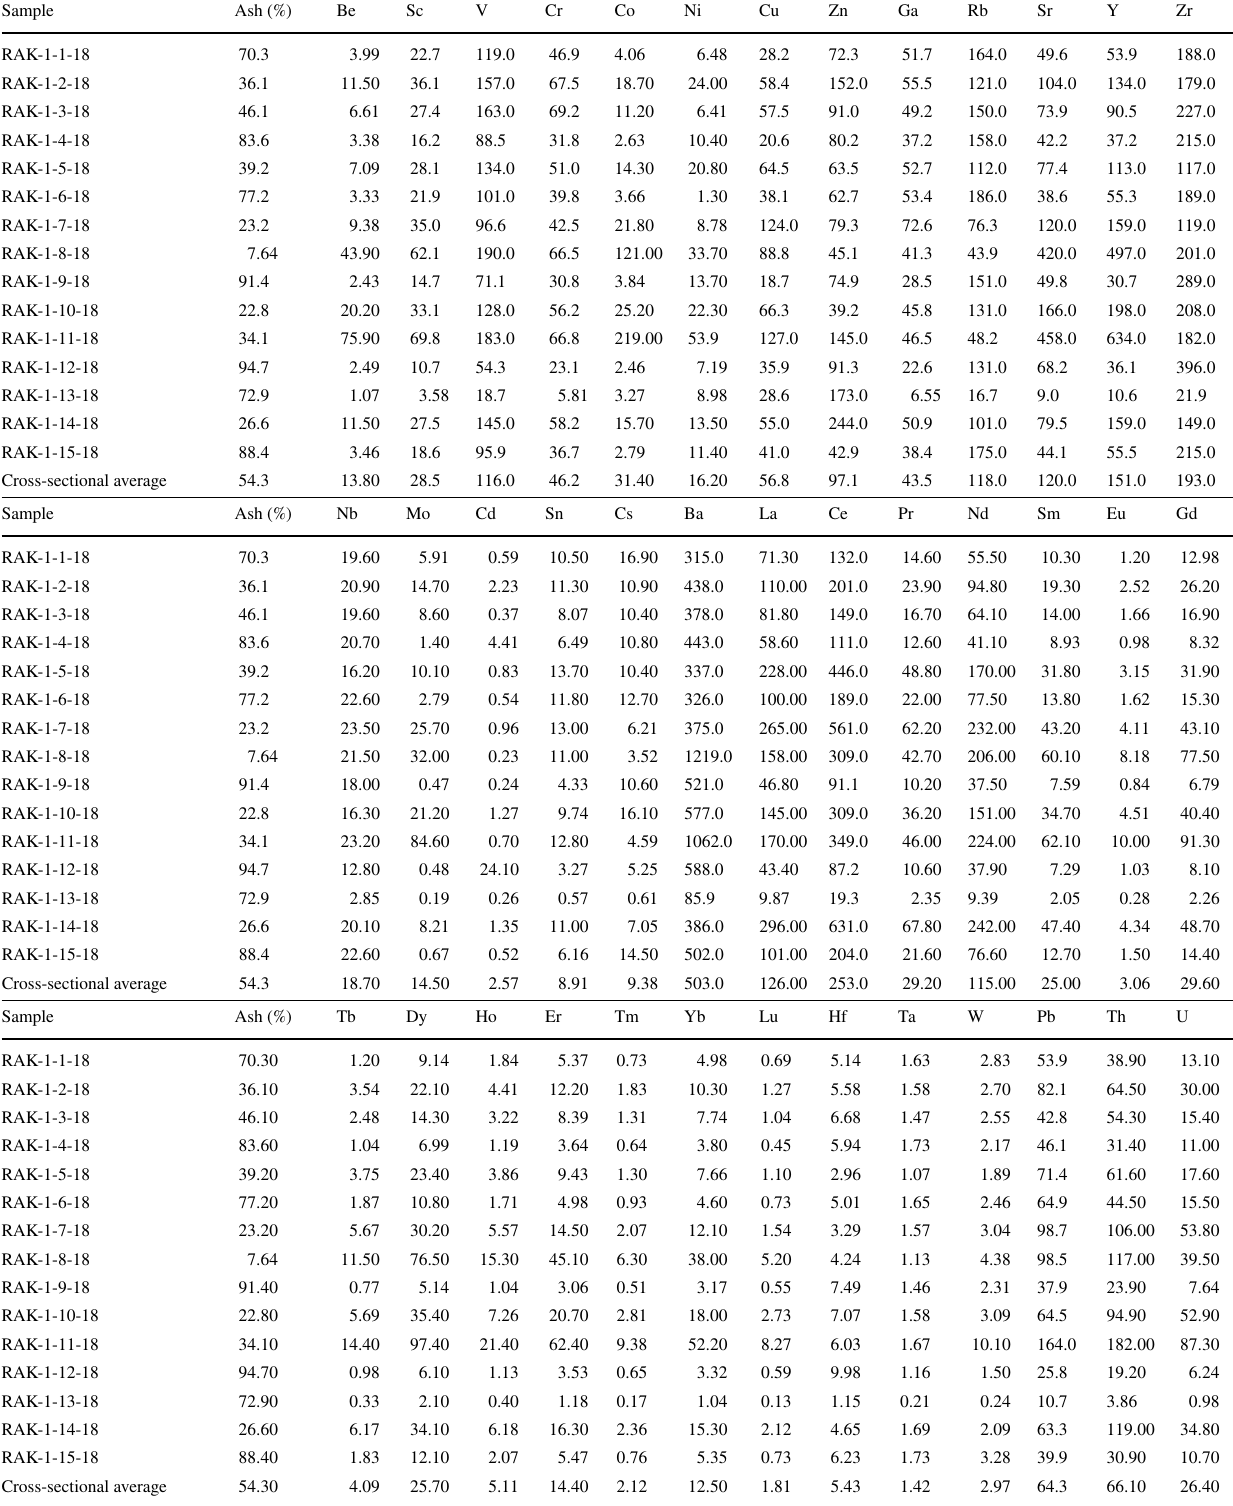
Table 2 Concentration of rare elements (g/t) in coal ash and rocks of coal-bearing sediments of the "East" section (analyzed by atomic emission spectrometry)